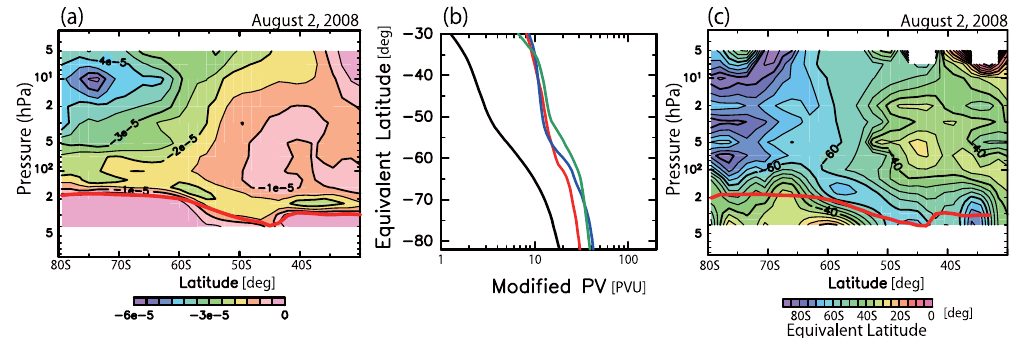
Fig. 9. (a) A geographical latitude and pressure section of modified PV at 60 ◦ W. The red curve shows the tropopause on 2 August 2008. (b) Equivalent latitudes as functions of absolute value of modified PV on 300 (black), 400 (red), 500 (blue), and 600K (green) isentropic surfaces. (c) The same as (a) but for equivalent